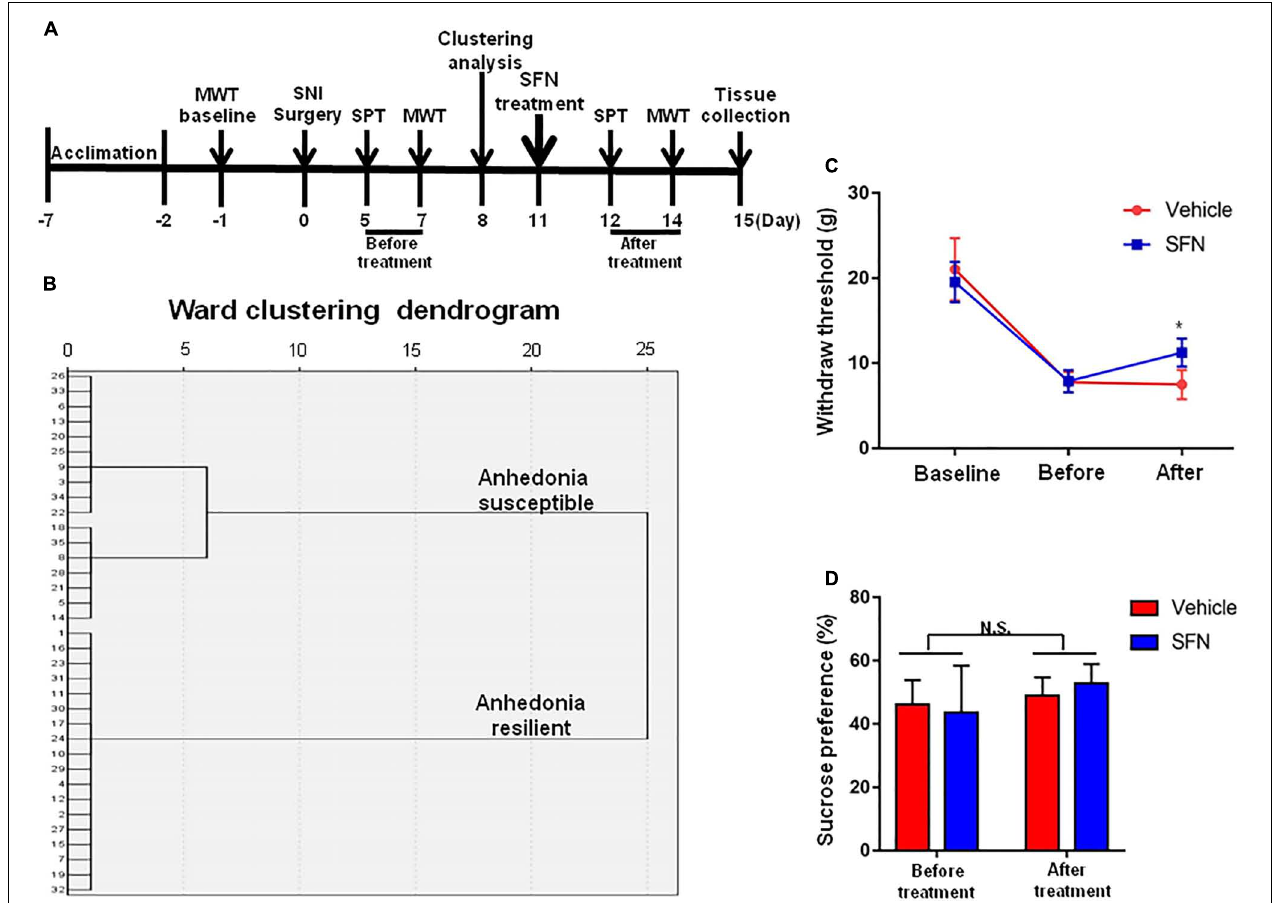
FIGURE 3 | Effects of SFN treatment after SNI surgery on the results of MWT and SPT. (A) The schedule of the experiment. SNI surgery was performed on day 0 after acclimation. SFN (30 mg/kg, i.p.) was administered on day 11. SPT was measured on day 5 and 12 after SNI, respectively. MWT was performed on day 7 and 14 after SNI, respectively. (B) Dendrogram of hierarchical clustering analysis. A total of 35 SNI rats were divided into anhedonia-susceptible and anhedonia-resilient groups by SPT results. Thirteen-seven of 35 SNI rats were anhedonia-susceptible phenotype. (C) MWT [Time: F ( 2 , 42 ) = 160.9 , P < 0.001; SFN: F ( 1 , 42 ) = 1.635 , P = 0.208; Interaction: F ( 2 , 42 ) = 6.284 , P = 0.0041]. Data are shown as mean ± SEM ( n = 8). ∗ P < 0.05, SFN group vs. vehicle group. (D) SPT [Time: F ( 1 , 28 ) = 3.361 , P = 0.0774; SFN: F ( 1 , 28 ) = 0.04322 , P = 0.8368; Interaction: F ( 1 , 28 ) = 0.9291 , P = 0.3434]. Data are shown as mean ± SEM ( n = 8). MWT, mechanical withdrawal test; N.S., not significant; SFN, sulforaphane; SNI, spared nerve injury; SPT, sucrose preference